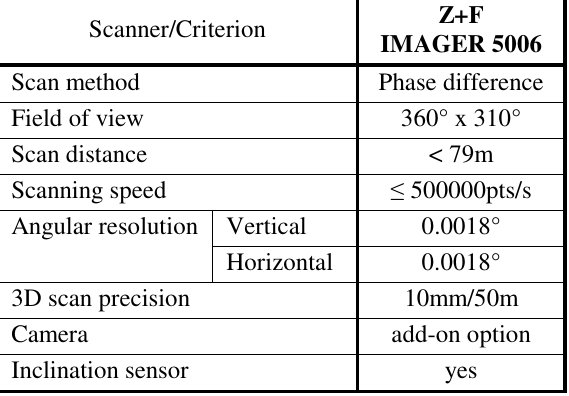
Table 1: Technical specifications of the IMAGER 5006